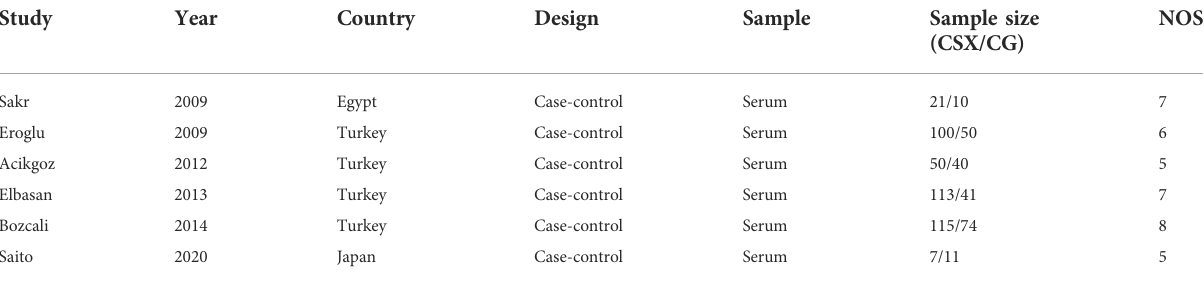
TABLE 1 Description of included